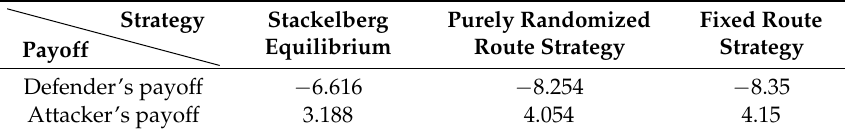
Table 5. Players’ payoffs under three different patrolling